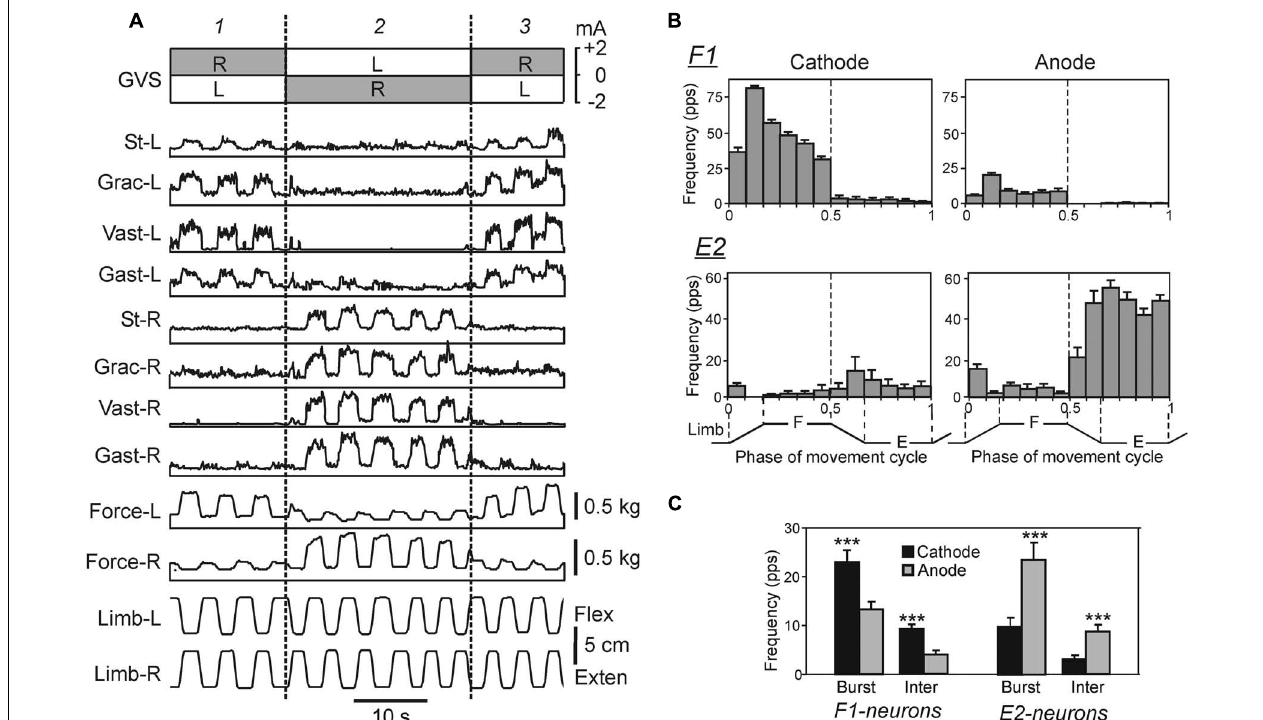
FIGURE 8 | Effects of galvanic vestibular stimulation on postural limb reflexes and on spinal neurons presumably mediating these reflexes. (A) An example of GVS effects on PLRs. The configuration of GVS was repetitively changed, so that the anode was on the right side (R) and cathode was on the left side (L) during time periods 1 , and 3 ; the position of anode and cathode was opposite during period 2 . The reflex responses of the limb (the EMG value in eight tested muscles and the force magnitude) were much larger when the cathode was ipsilateral to the limb than when the anode was ipsilateral to this limb. St, semitendinosus; Grac, gracilis; Gast, gastrocnemius. (B) Examples of